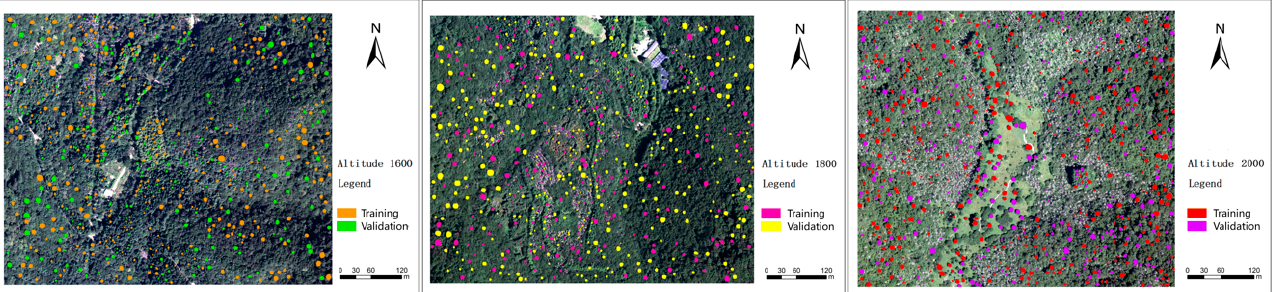
Figure 2. Distribution of samples in different altitude study areas.